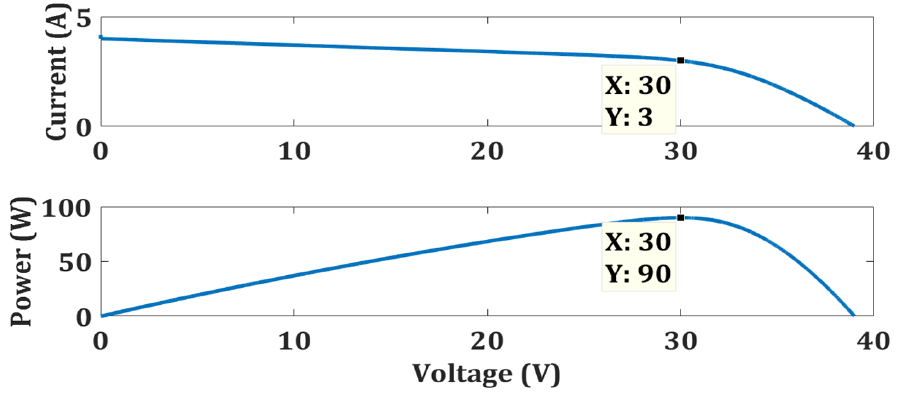
Figure 19. Characteristic curves of 3 S PV system for test case 1.